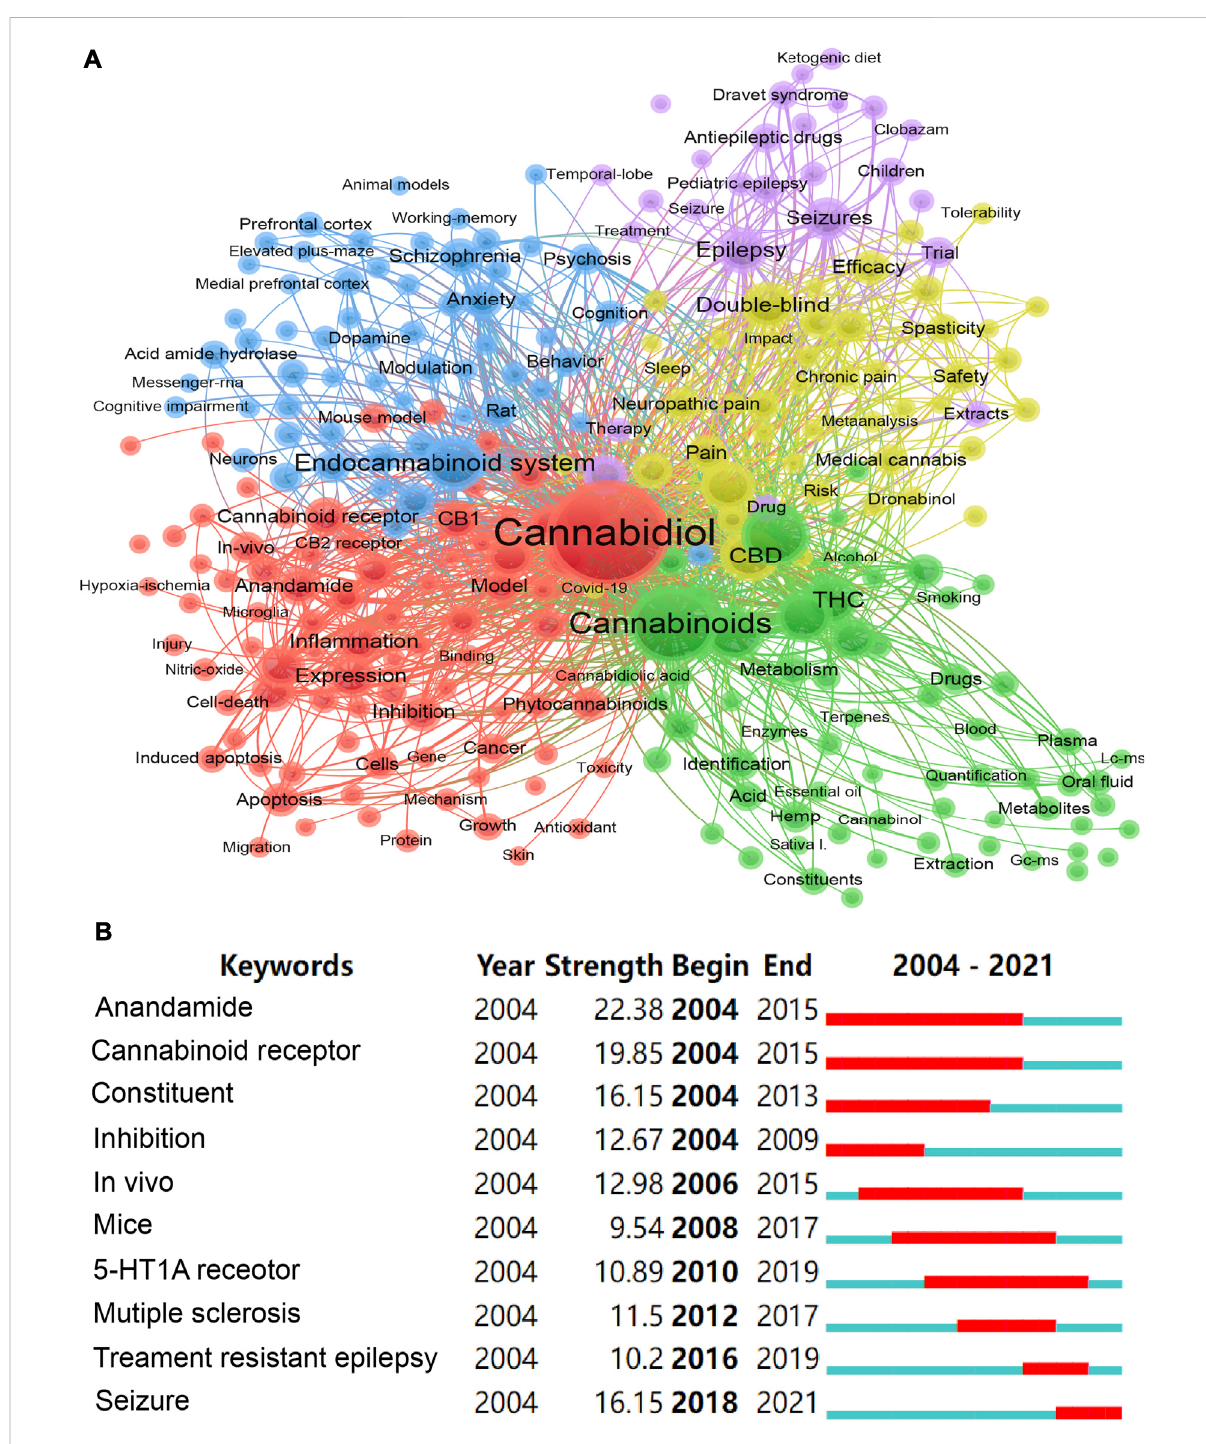
FIGURE 5 Keywords analyses. (A) The network of the keywords co-occurrence and clustering. (B) The top 10 keywords with the strongest